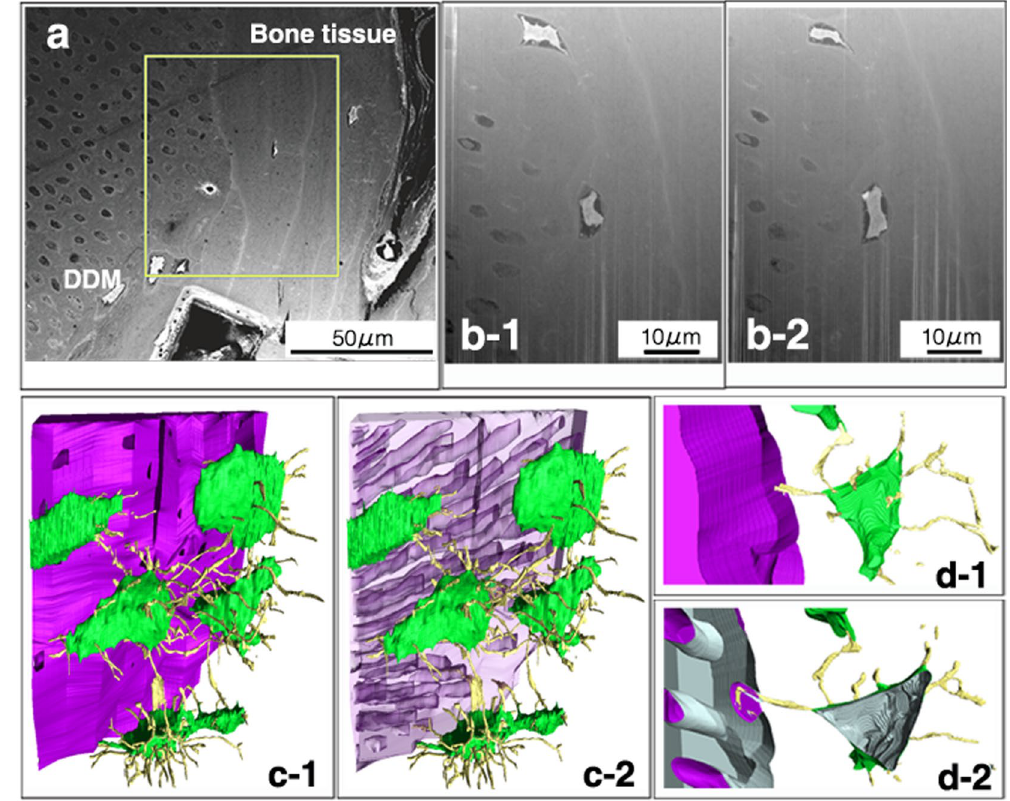
Figure 3. Focused ion beam/scanning electron microscopy (FIB/SEM) tomography and three-dimensional (3D)-structure reconstruction. ( a ) The FIB/SEM tomography image of the interface between the implanted demineralised dentin matrix (DDM) and surrounding new bone. The left side shows the DDM, and the right side shows the newly formed bone tissue. ( b ) Higher magnification of the square area in panel ( a ). Some osteocytes surround the DDM. Images b-1 and b-2 are serial sections. ( c ) The 3D reconstruction image of the square area. Image c-2 is the DDM skeleton image of image c-1. The 3D reconstruction image confirms that osteocytes form a network with cell processes. ( d ) Higher magnification of the interface between the DDM and new bone in the 3D reconstruction image. Image d-2 is the torn section of image d-1. Some cell processes of the osteocytes extend into the dentinal tubules in the torn